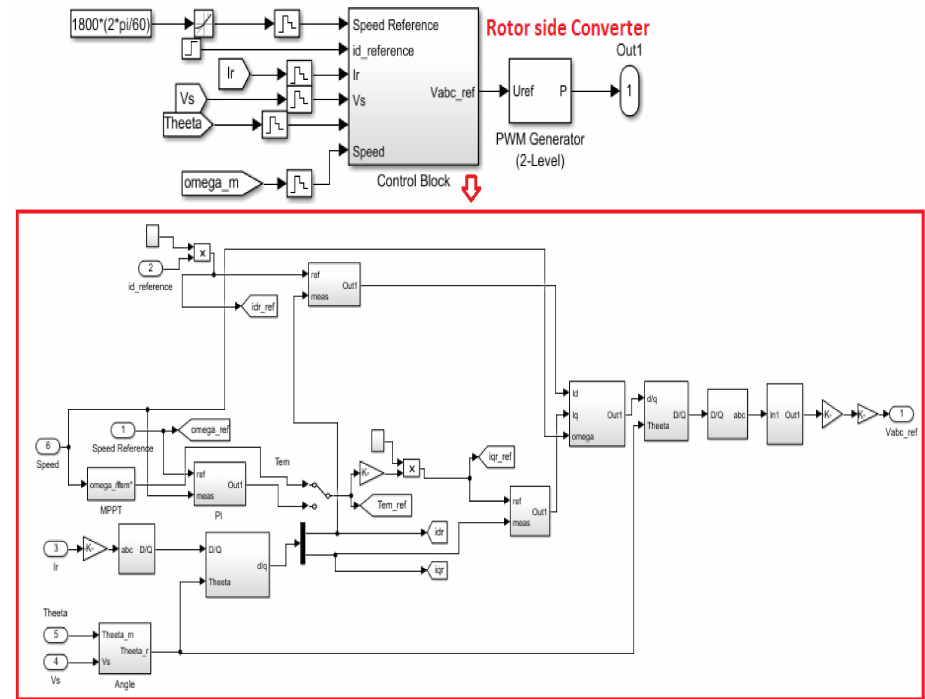
Figure 6. Rotor Side